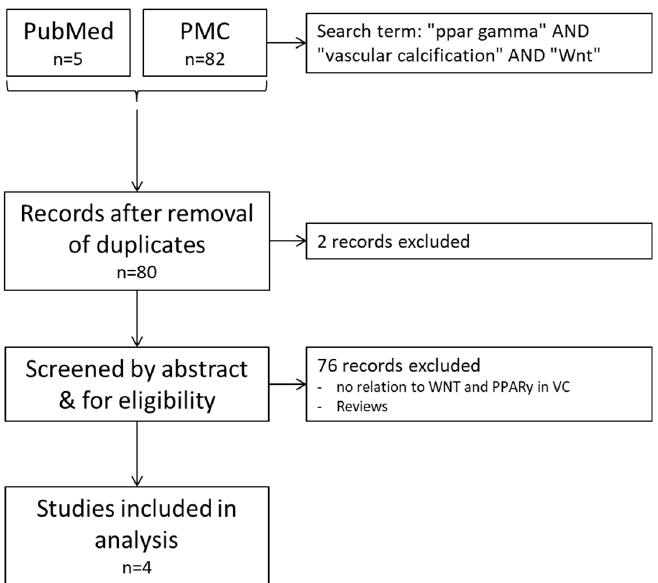
Figure A1. Flow chart to illustrate the systematic search protocol to identify relevant literature in the PubMed and PMC databases.